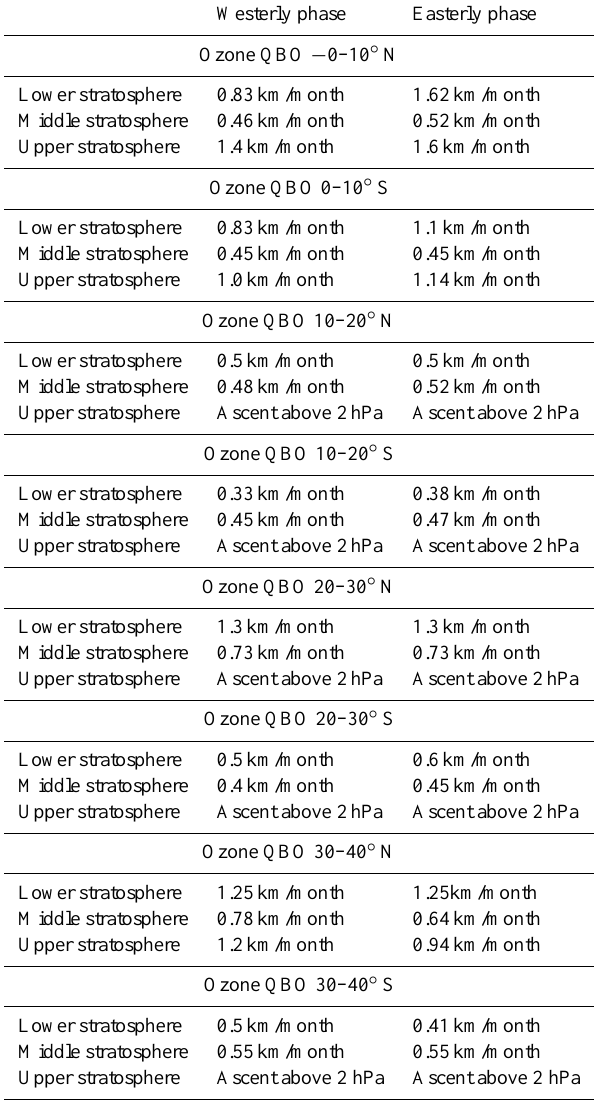
Table 1. Vertical variation of descent rate of westerly and easterly phase over different latitudinal